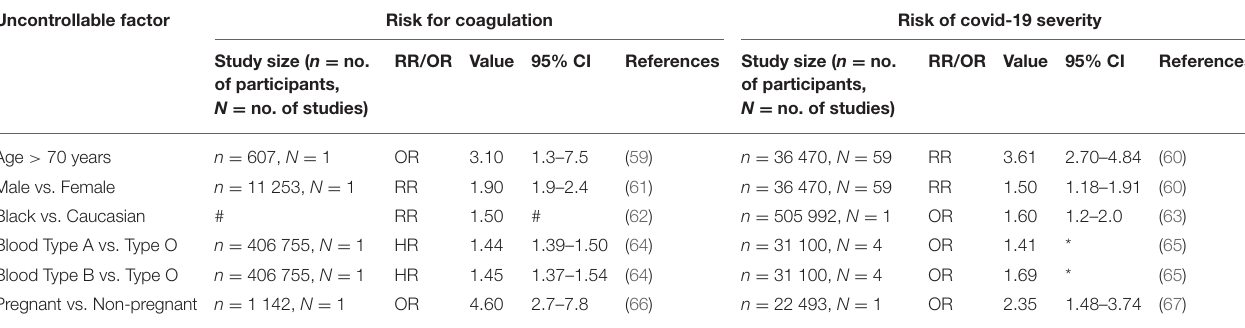
TABLE 1 | Data for the qualitative comparison of risk factors between coagulation and Covid-19 severity. Uncontrollable factor